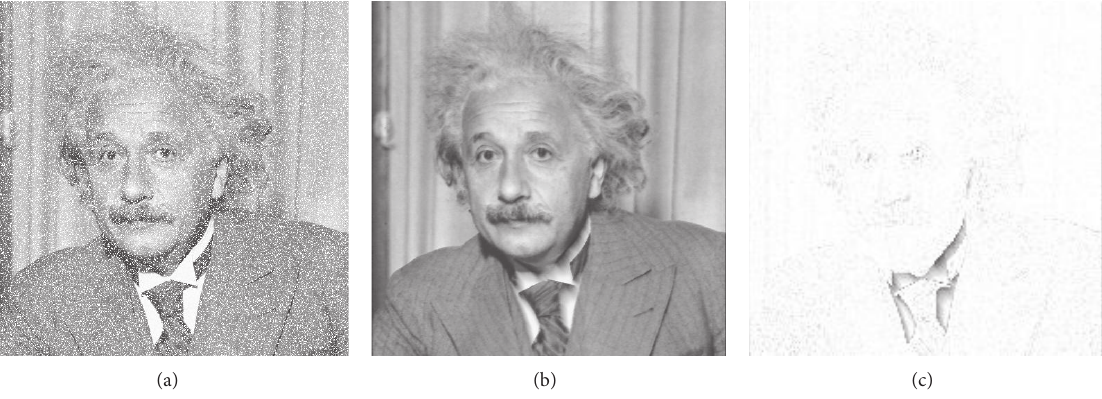
Figure 4: Regression example. (a) 20% noisy image; (b) reconstructed image; (c) difference with original (to improve visualisation, the darker values correspond to higher